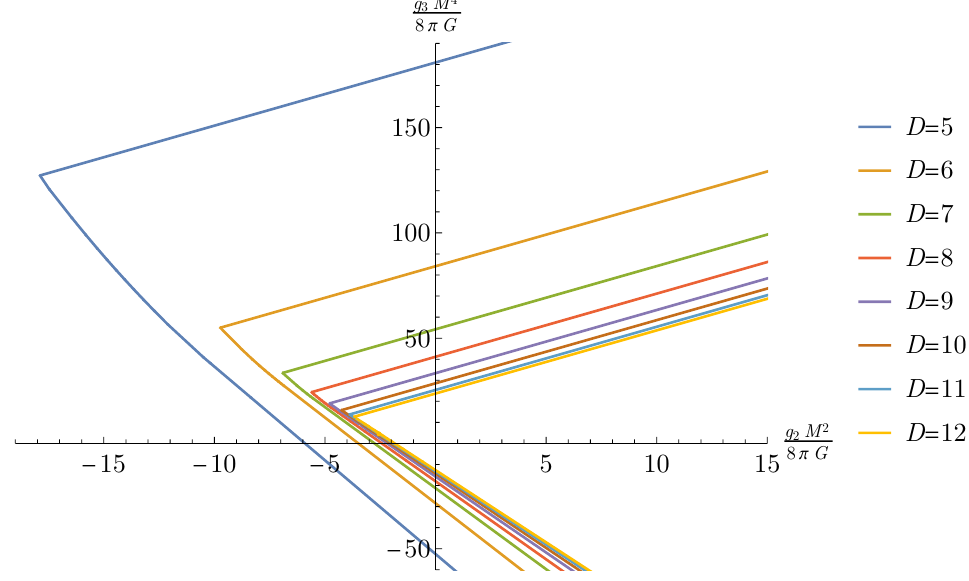
Figure 4 . Allowed regions for g 2 and g 3 in a theory of a scalar coupled to gravity in flat space in dimensions D = 5 , . . . , 12 , with heavy mass scale M . For each curve, the region to the right is allowed and the region to the left is disallowed. Each bound was computed using a 17-dimensional space of functionals, listed in table 2. We give more details on the numerical computation in appendix A. The inequalities plotted here are listed in table